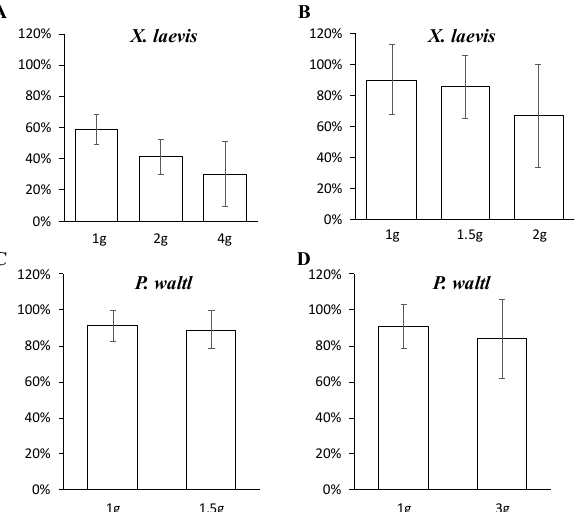
Figure 5. Examples of survival rates of anuran and urodela embryos, or tadpoles, raised under different levels of hypergravity for different durations. ( A ) Survival rates of X. laevis after 3 weeks of development at 2 or 4 g by comparison to 1 g controls. Embryos were at stage 8 of development at the beginning of the experiment (~5 h post-fertilization). ( B ) Survival rates of X. laevis after 2 weeks of development at 1.5 or 2 g by comparison to 1 g controls. Embryos were at stages 55–60 of development at the beginning of the experiment (~32–46 days post fertilization). ( C ) Survival rates of P. waltl after 10 days of development at 1.5 g by comparison to 1 g controls. Embryos were at stages 19–20 of development at the beginning of the experiment (~77 h post fertilization). ( D ) Survival rates of P. waltl after 10 days of development at 3 g by comparison to 1 g controls. Embryos were at stages 19–20 of development at the beginning of the experiment (~77 h post-fertilization). Aquariums containing 0.5 L of water and rotor 1 (Figure 2) were used to obtain the results presented in panels ( A , B ). Miniaquariums without a food supply and a water cleaning system and rotor 3 (Figure 4) or rotor 1 (Figure 2) were used to obtain the results presented in panels ( C , D ). No statistically significant differences could be detected. Lower survival rates are observed in panel ( A ) because embryos were not selected before initiating the experiment. Consequently, some unfertilized eggs were included.